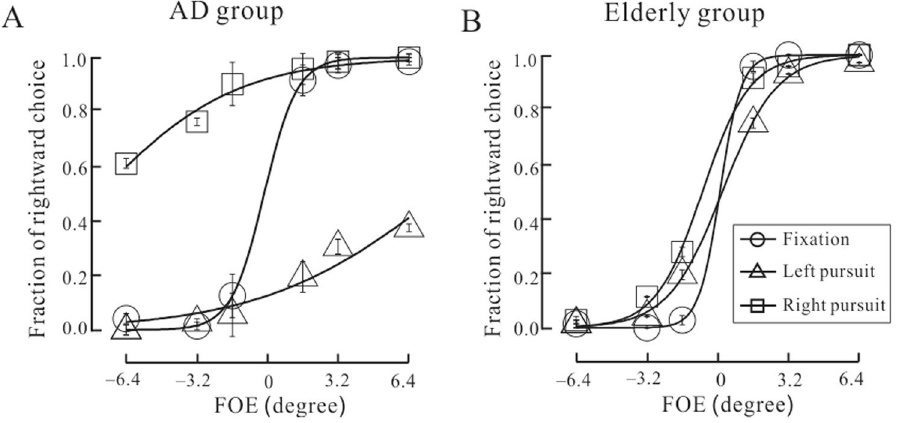
Figure 2. Psychometric performance of self-motion perception in the fixation and pursuit conditions for AD patients ( A ) and healthy elderly participants ( B ). Error bars denote mean and